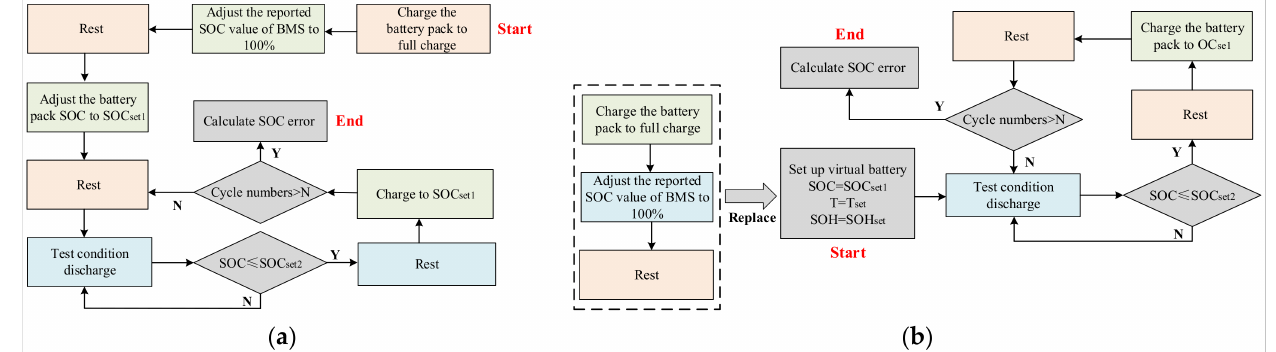
Figure 6. SOC cumulative error testing: ( a ) based on actual battery pack; ( b ) based on virtual battery packs.